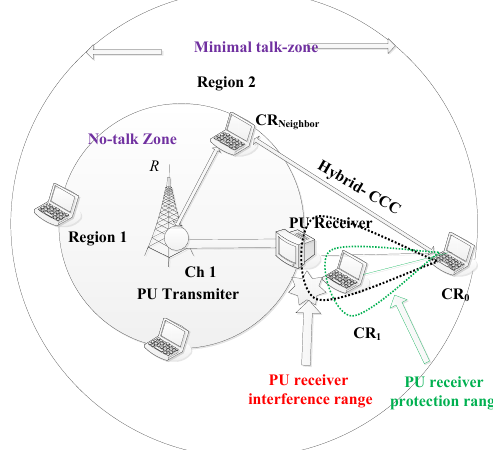
Figure 8. PU receiver interference scenario at no-talk